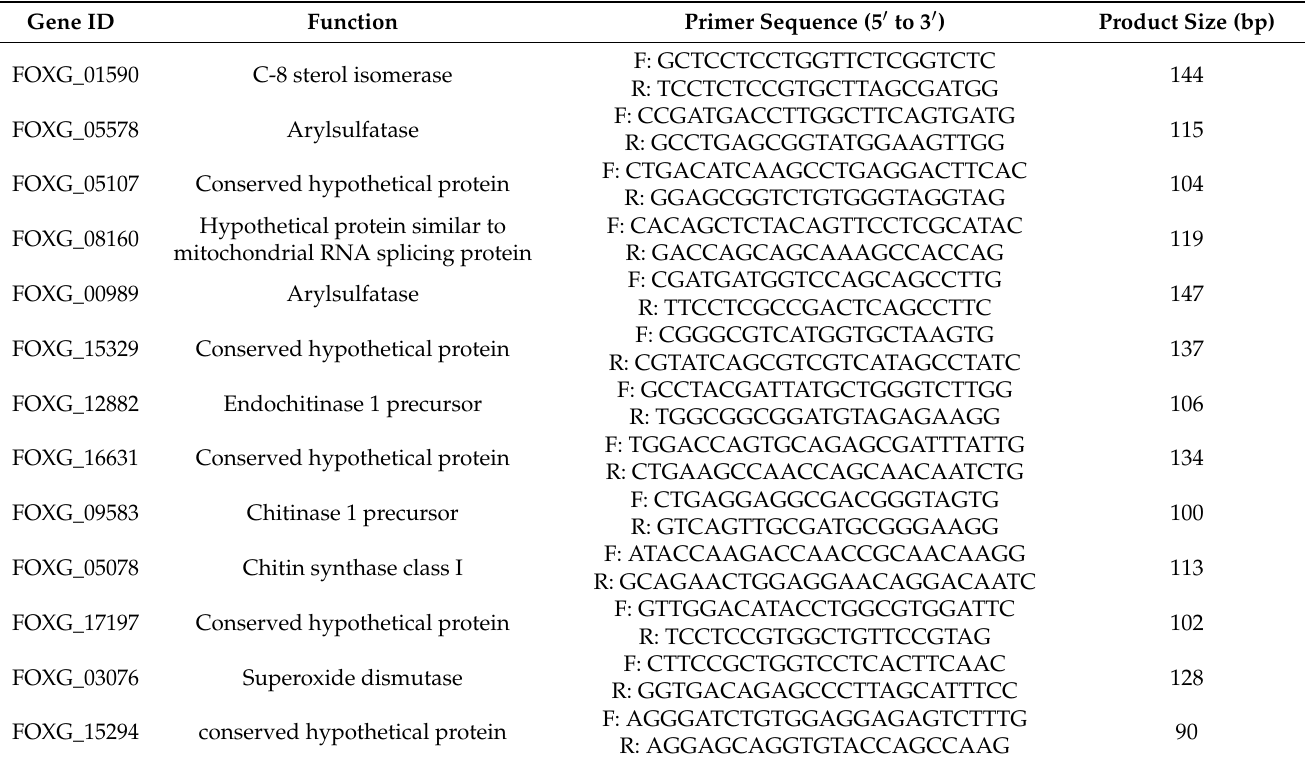
Table 1. Primer sequences of differentially expressed genes in Fusarium oxysporum for qRT-PCR